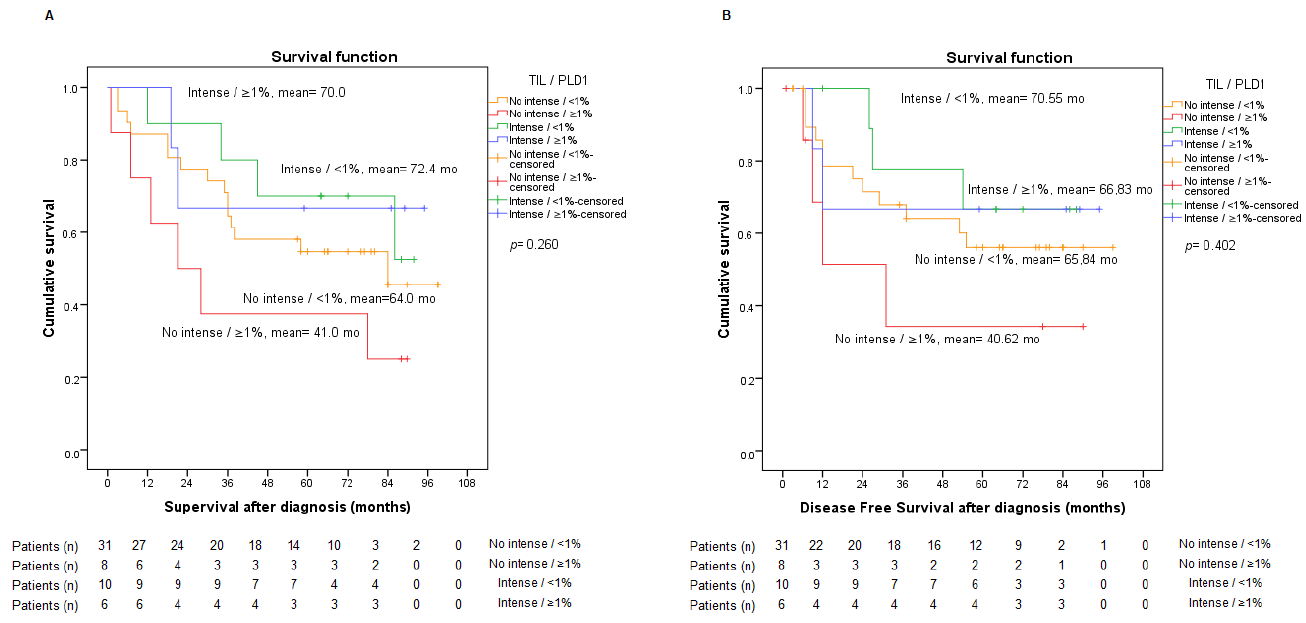
Figure 4. Analysis of overall survival ( A ) and disease-free survival ( B ) according to PD-L1 expression <1% or ≥ 1% and intense or non-intense TIL.